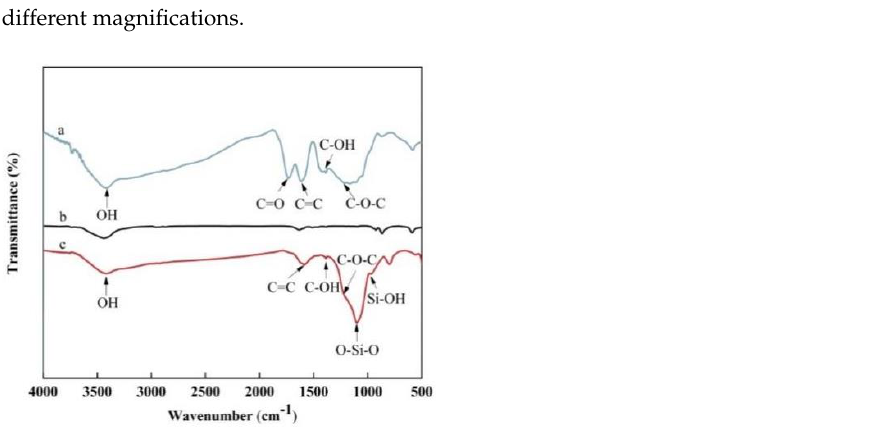
Figure 2. FT-IR spectrum of graphene GO (a), RGO (b), and RGO-SiO 2 (c).